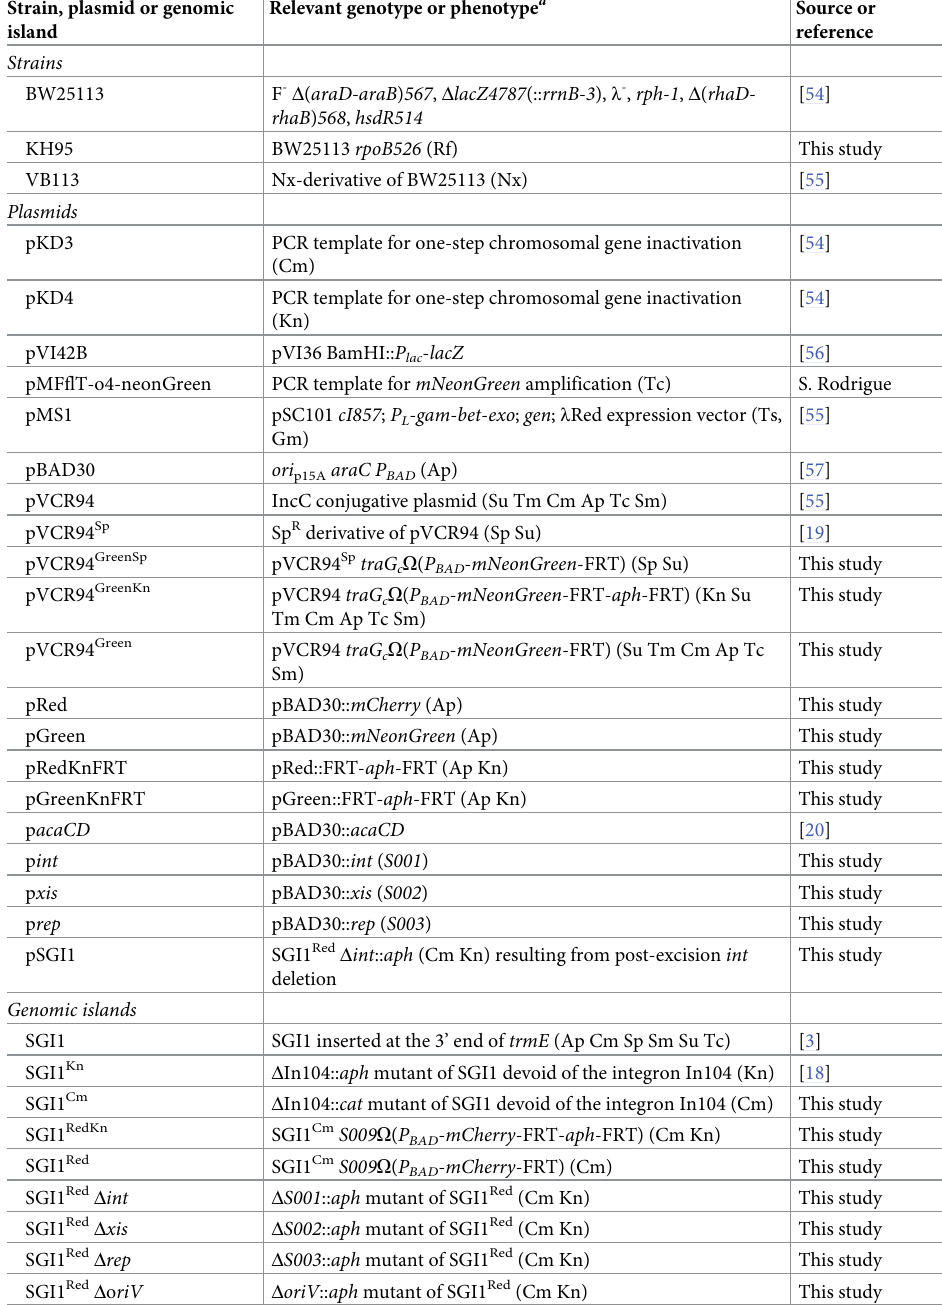
Table 1. E . coli K-12 derivative strains, plasmids and genomic islands used in this study. Strain, plasmid or genomic